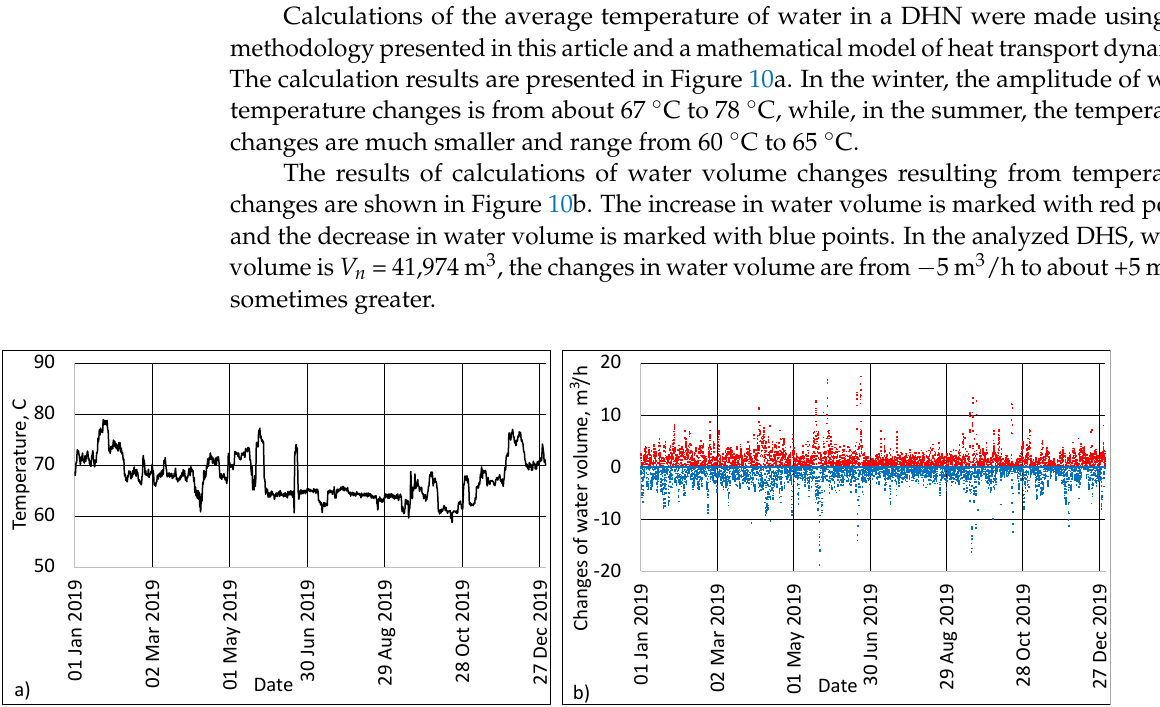
Figure 10. Results of calculations (hourly data): ( a ) values of average temperature of water in the DHN; ( b ) changes in water volume in the DHN.